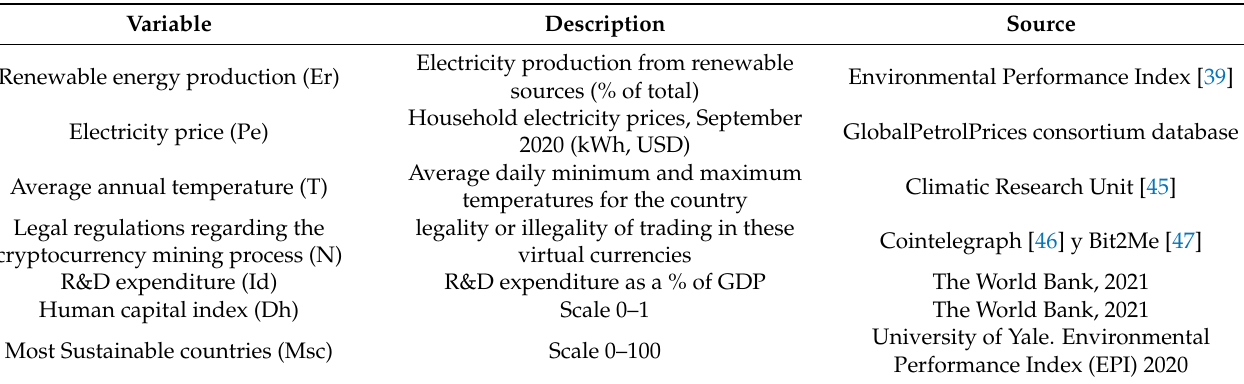
Table 1. Selection of